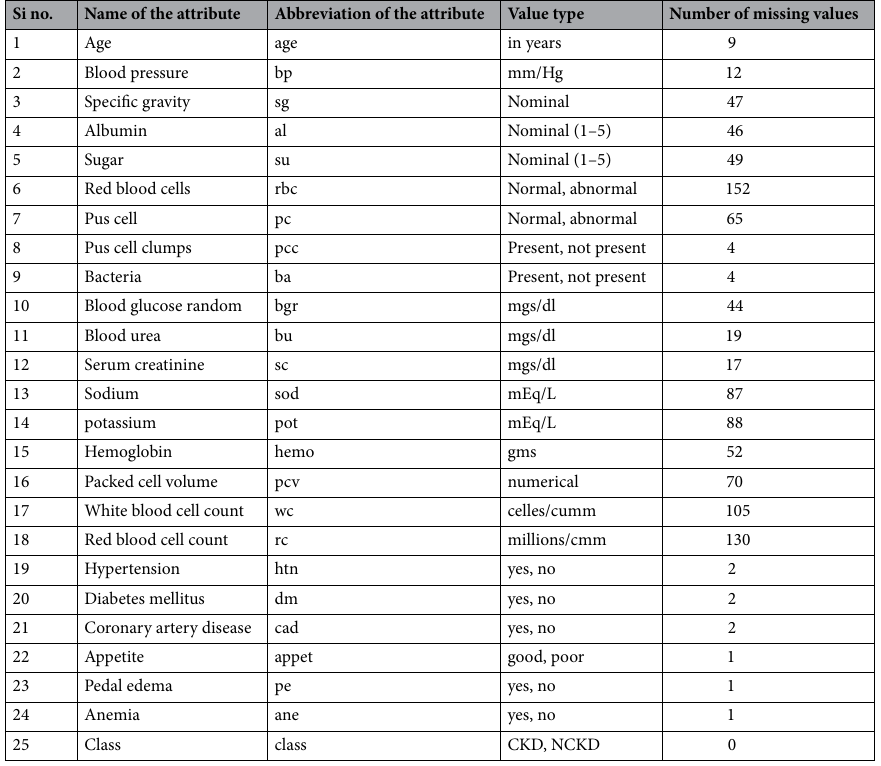
Table 1. Attribution of the CKD dataset.